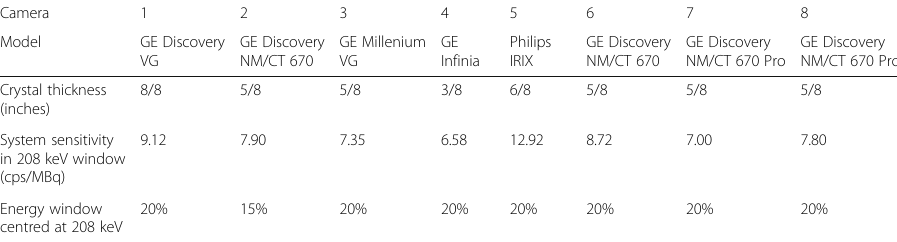
Table 1 Summary of the key characteristics for each of the camera systems, which were taken into account for the quantitative SPECT reconstruction, as well as the planar image quantification, used in the protocol. Medium-energy general purpose collimators were employed for all camera systems, and an energy window centred over the 208-keV photo peak